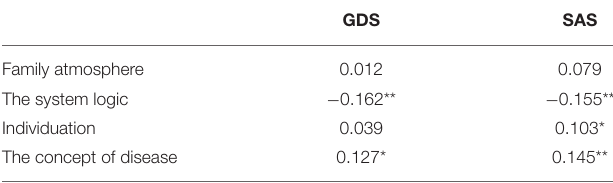
TABLE 3 | Pearson’s correlation between the dimensions scores of family dynamics and total scores of grandparents’ anxiety-depression. ( r